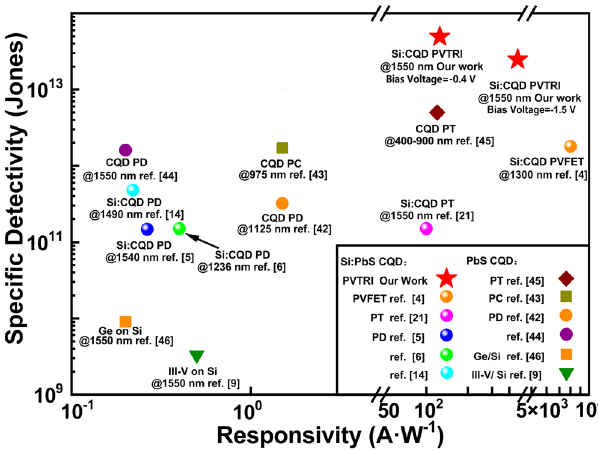
Fig. 6 Performance comparision of the representative PbS CQDs and silicon photodectors. Responsivity and detectivity comparison between our PVTRI and the representative reported PbS CQDs and infrared sensitized